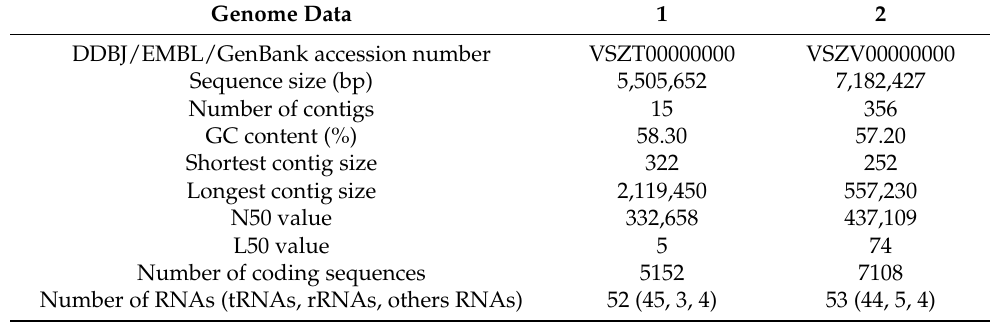
Table 3. Genome characteristics of 1, Phyllobacterium endophyticum PEPV15 T ; 2, Rhizobium laguerreae